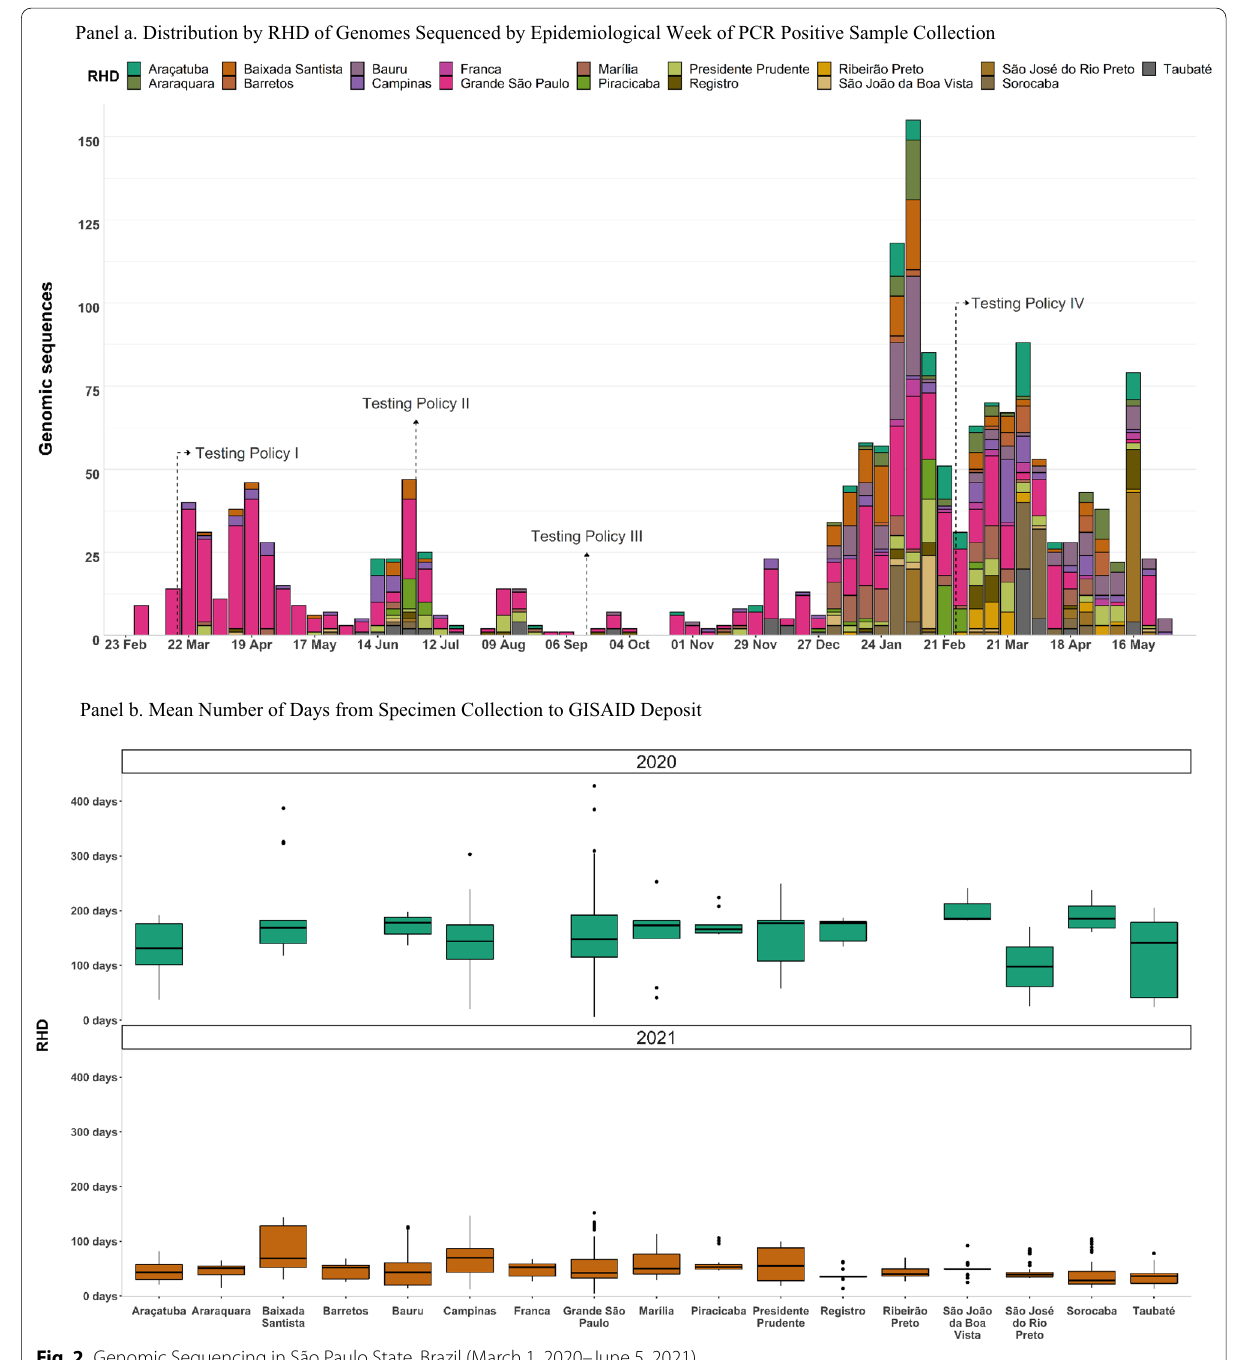
Panel b. Mean Number of Days from Specimen Collection to GISAID